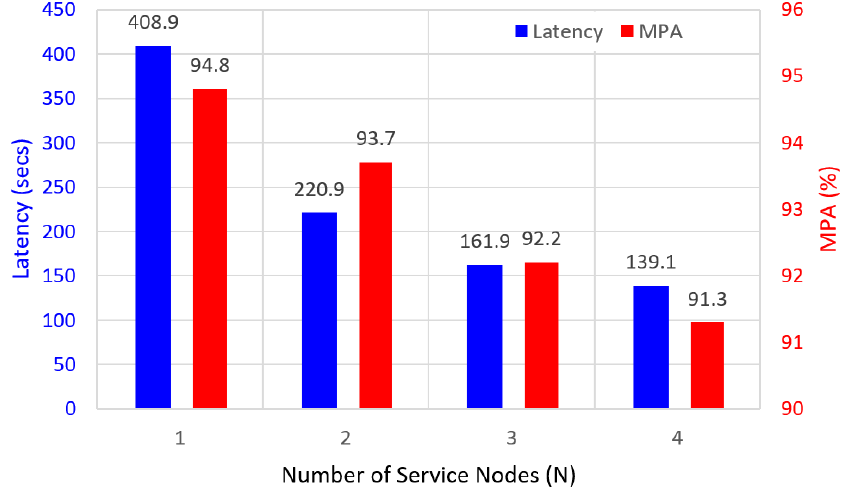
Figure 4. Effect of varying N on latency and mean precision accuracy.